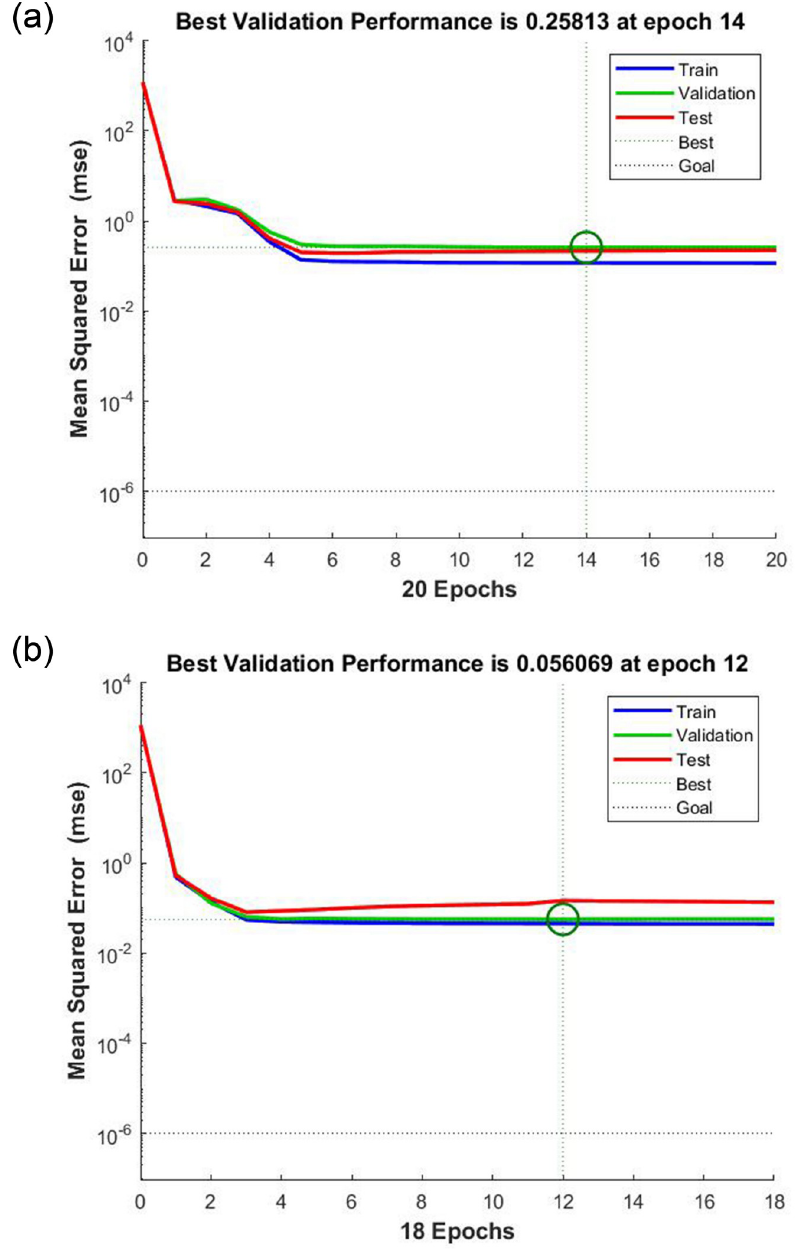
Fig 7. Variations of MSE value for training, testing and validation datasets during the training process of the optimized ANNs; a) the LM-LS-21 model for 2019 data, b) the LM-LS-27 model for 2021